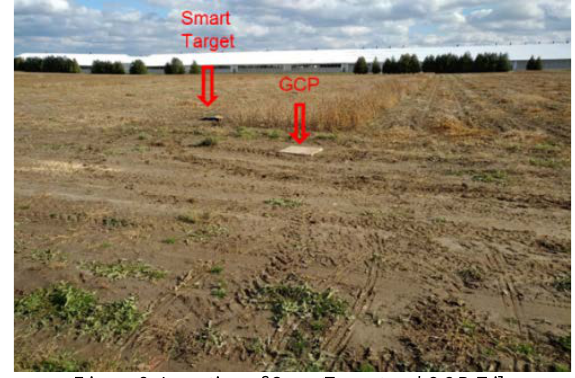
Figure 8: Location of SmartTarget and GCP Tile